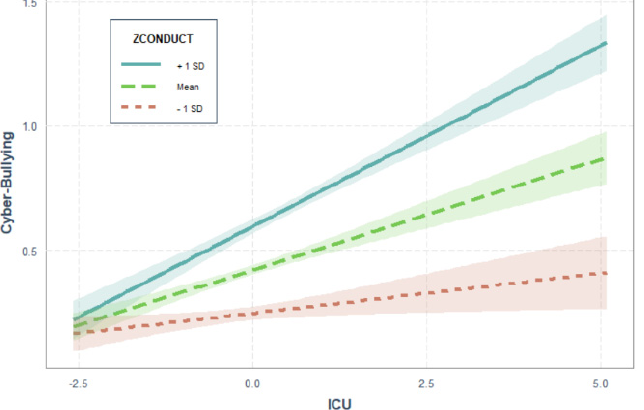
Figure 1. Interaction between CU traits and conduct problems on cyberbullying perpetration.